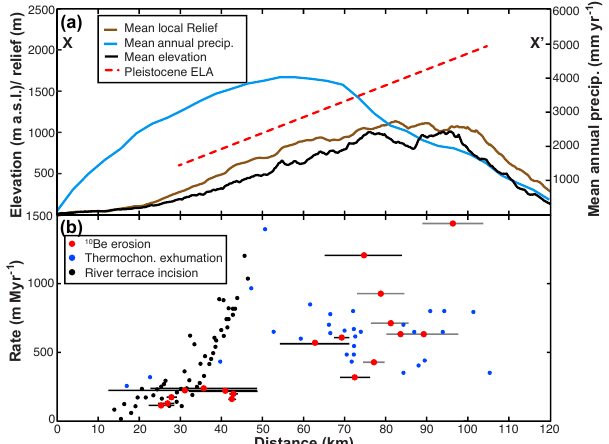
Figure 7. Comparison between estimated erosion and relief across the Olympic Mountains. (a) Elevation and climate data across the Olympic Mountain range parallel to the direction of tectonic con- vergence ( ∼ 54 ◦ ). Maximum and mean elevations are shown in thin and thick black lines, respectively. Mean annual precipitation data (Daly et al., 1994) are shown in blue. Equilibrium line alti- tude (ELA) data (Porter, 1964) are represented by a red trend line. (b) The blue circles show estimated rock uplift rates from apatite fission track data from Brandon et al. (1998). Black circles are rock uplift rate estimates from Pazzaglia and Brandon (2001) based on river terrace incision. Basin-averaged erosion rates in this study are shown in red circles with bars denoting the width of the basins. See Fig. 1a for cross-section